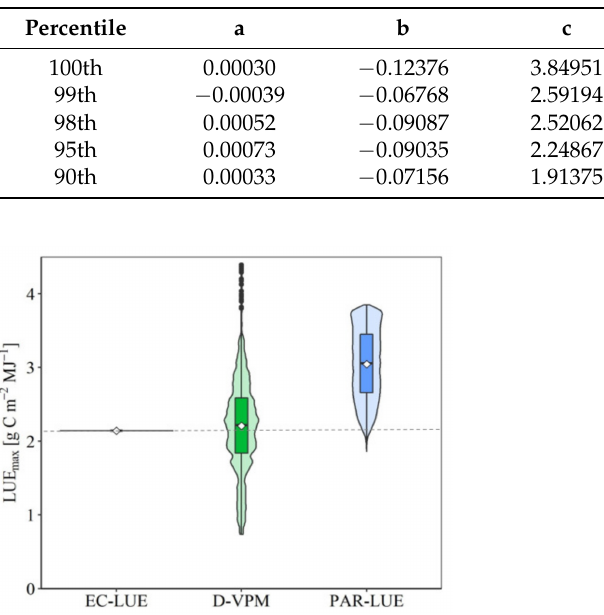
Table 1. PAR- E max estimation coefficients and GPP estimation accuracy under different sampling percentiles.